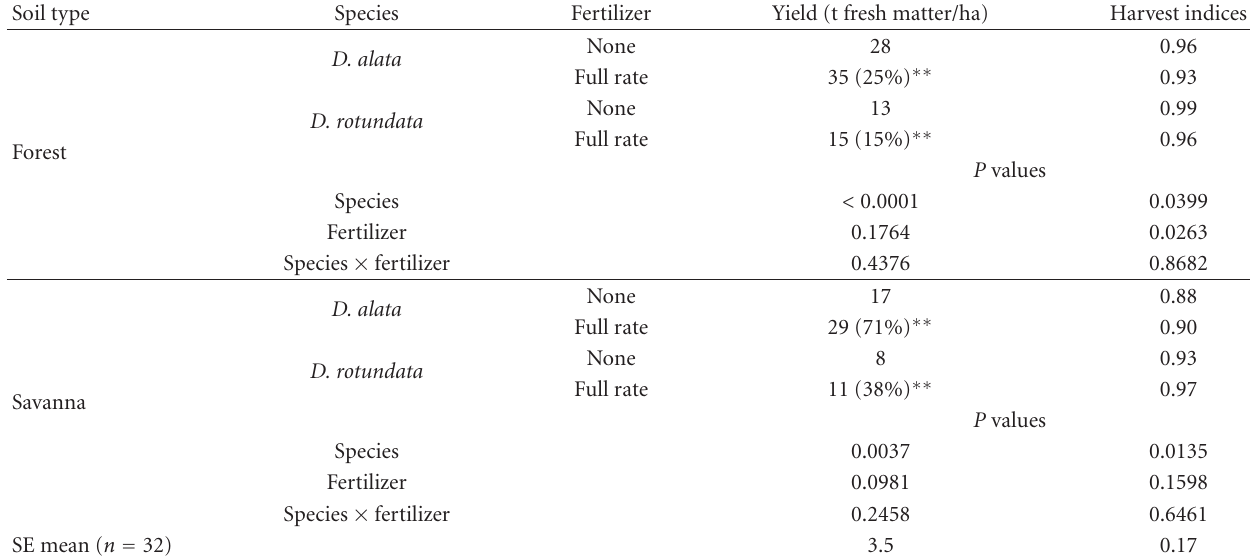
Table 3: Impact of soil type and fertilizers on tuber yields and harvest index (HI) of Dioscorea spp.